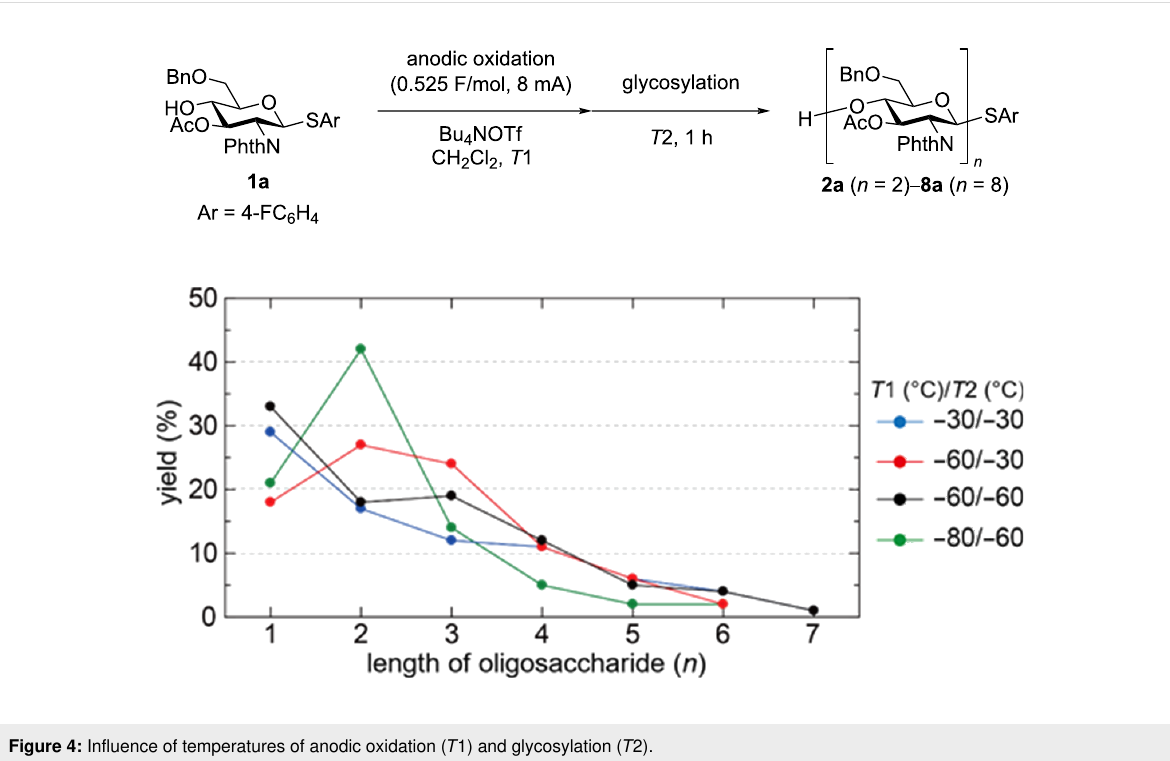
Figure 4: Influence of temperatures of anodic oxidation ( T 1) and glycosylation ( T 2).